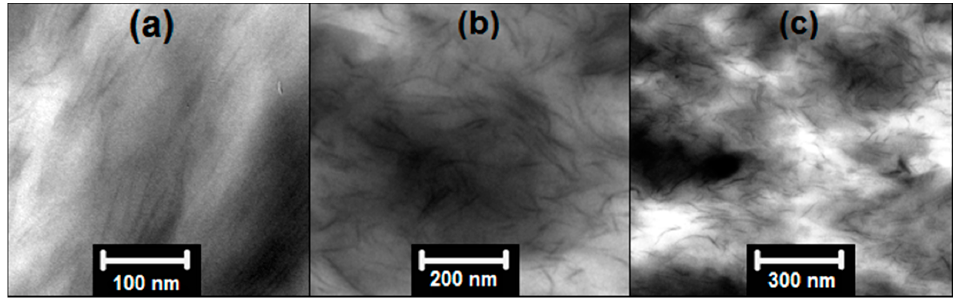
Figure 3. TEM images of nanocomposites with 10 wt % of nanoparticles: ( a ) PP/LSN; ( b ) PP/C20A; and ( c ) PA6/C30B.